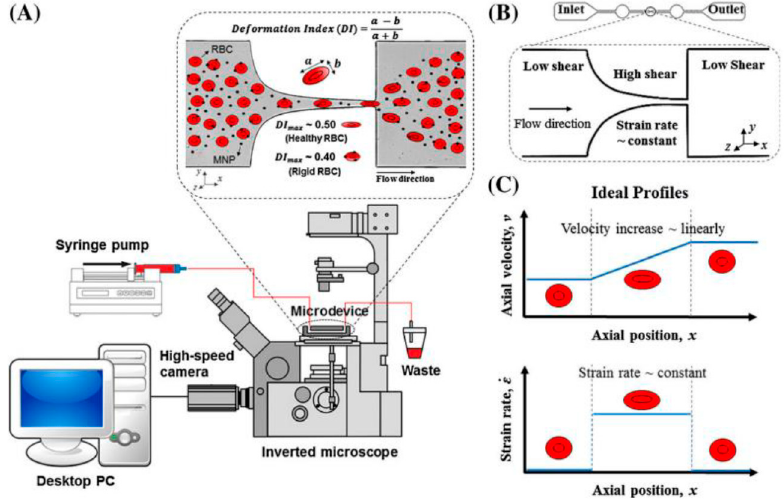
Figure 4. Schematic representation of NPs hemocompatibility evaluation. ( A ) Experimental setup. ( B ) Microchannel geometry. ( C ) Condition profiles present in the hyperbolic channel. Reprinted from [136]. 2016 Springer